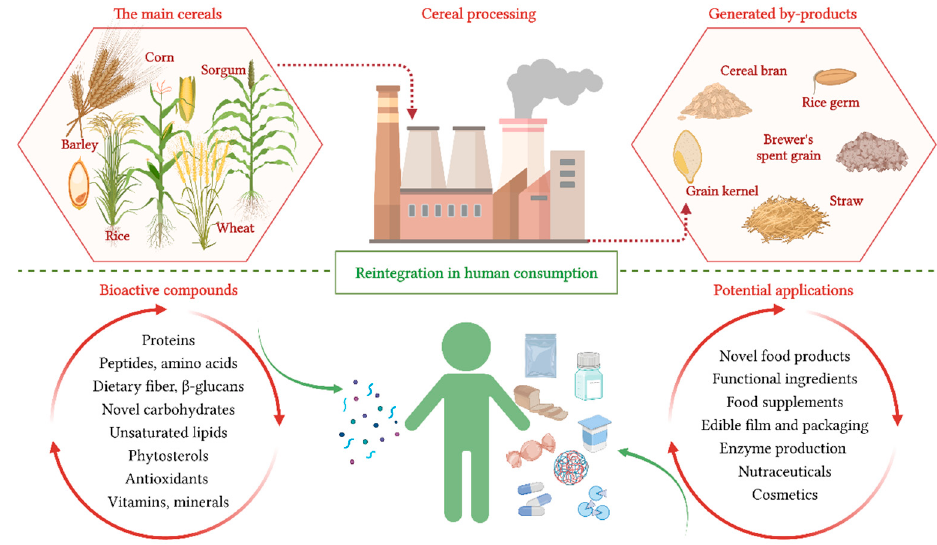
Figure 1. Reintegration of cereal by ‐ products in human consumption.